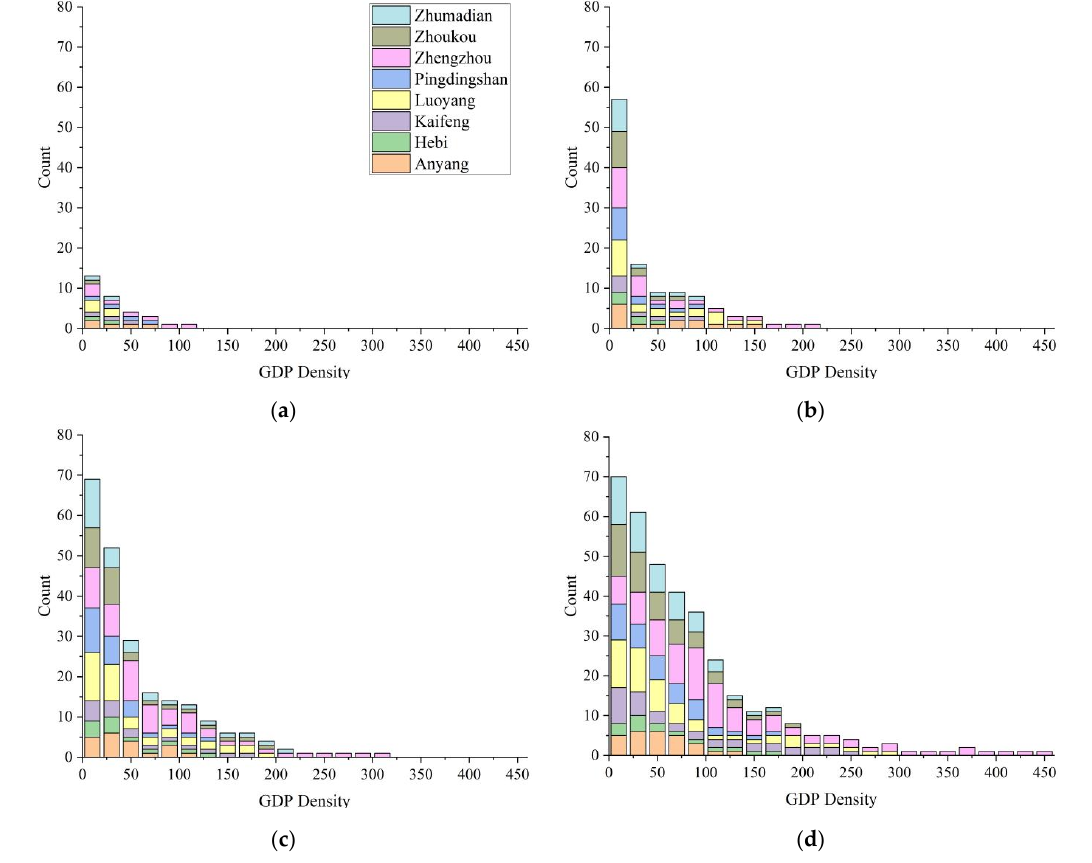
Figure 12. Histograms of tree structure information in eight cities in Henan Province: ( a ) 2001, ( b ) 2007, ( c ) 2014, and ( d ) 2020.